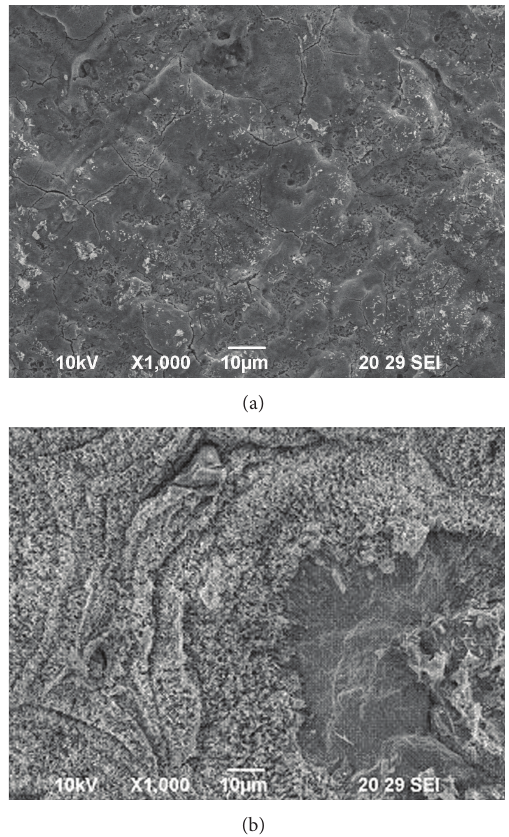
F 9: (a) SEM micrographs of mild steel surface in 1N H (b) SEM micrographs of mild steel surface in 1N